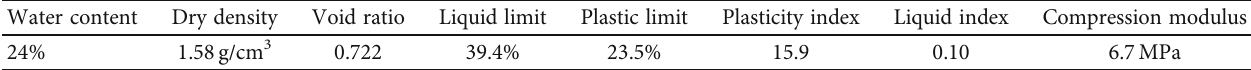
Figure 2: Particle size distribution ratio. Table 1: Physical indices of crushed silty clay after